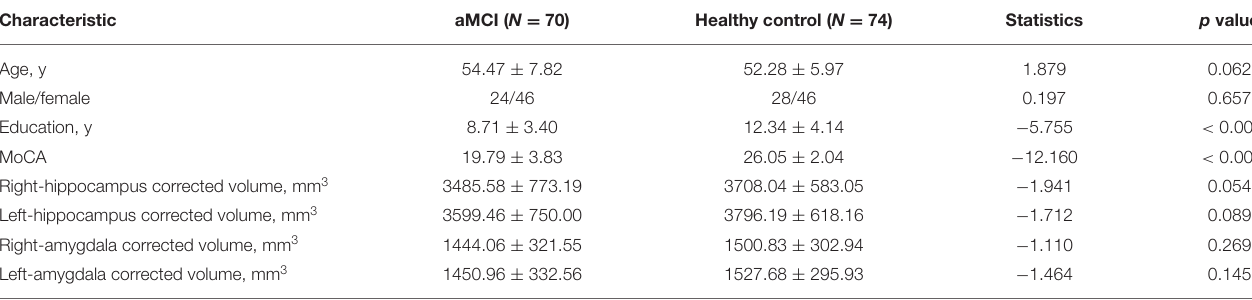
TABLE 1 | Demographics characteristics and psychometric